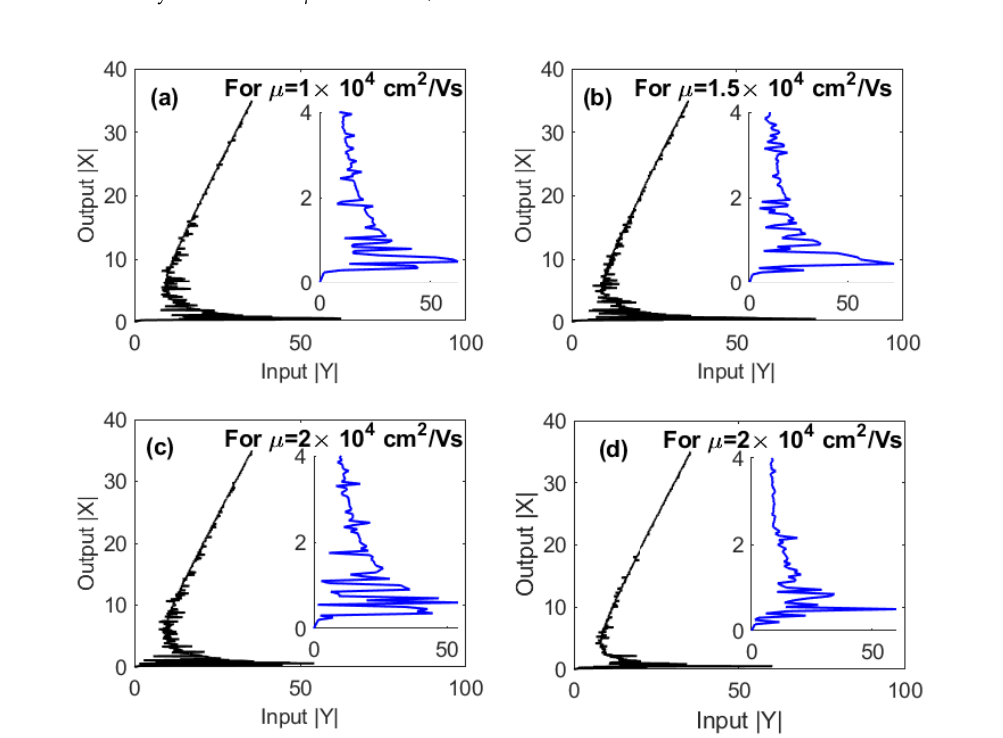
Figure 6. The output versus the input for different values of = 0.4. The other parameters were and γ 32 γ 12 and the mobility of GND was µ = 10 4 cm 2 /Vs.